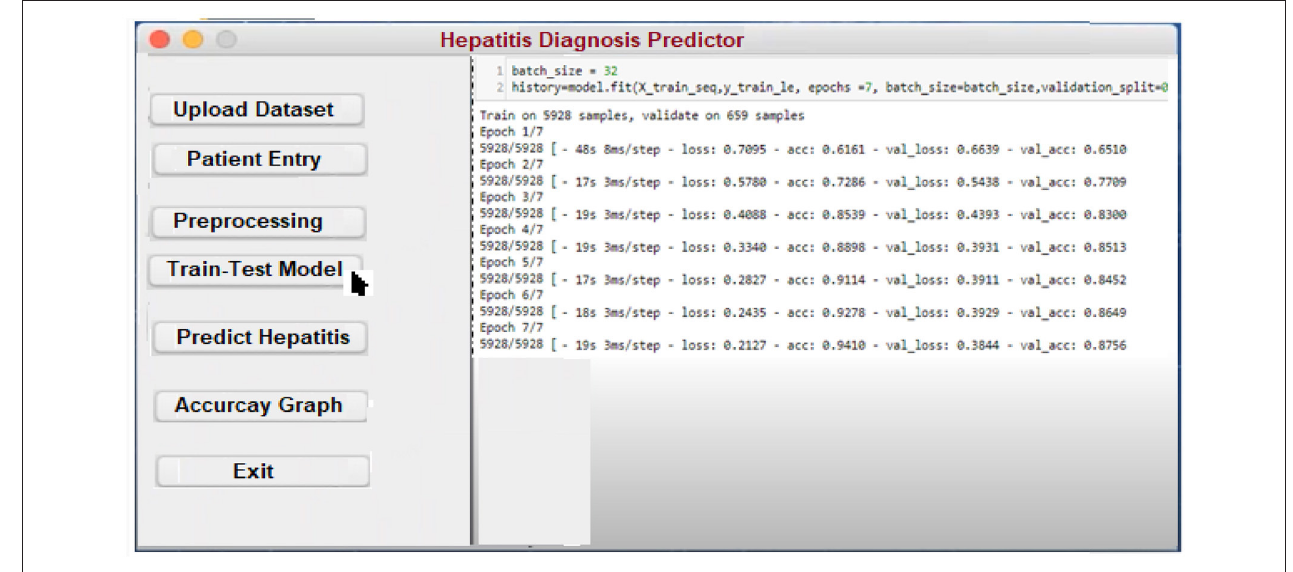
FIGURE 11 | Model training interface.